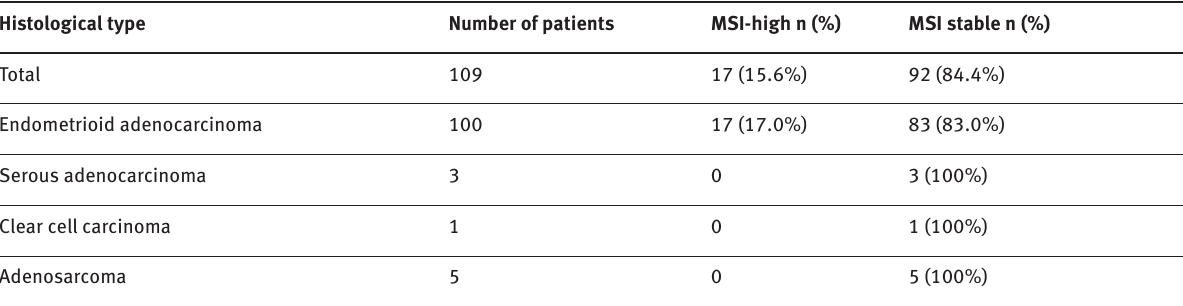
Table 1: Microsatellite instability (MSI) status according to the histological type of cancer Histological